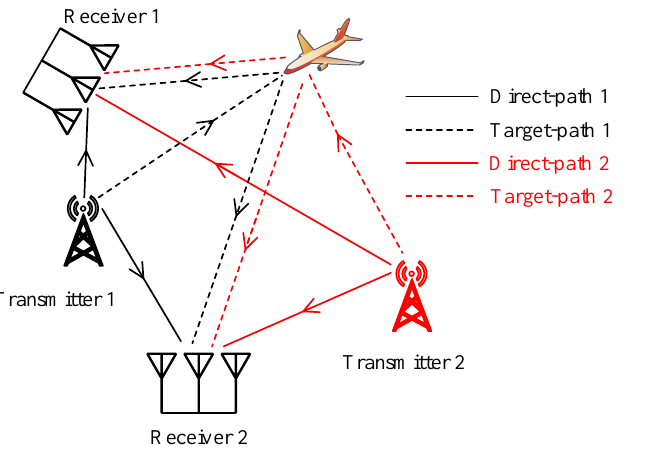
Figure 1. The notional passive MIMO radar consists of two multichannel receiver and two